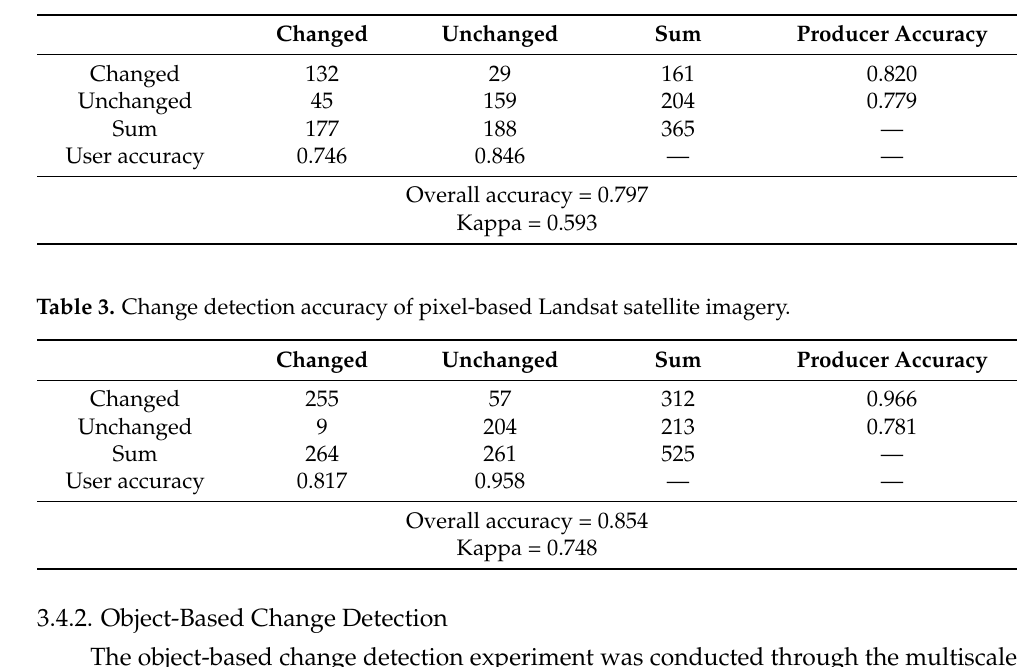
Table 2. Change detection accuracy of pixel-based GF-1 satellite imagery.